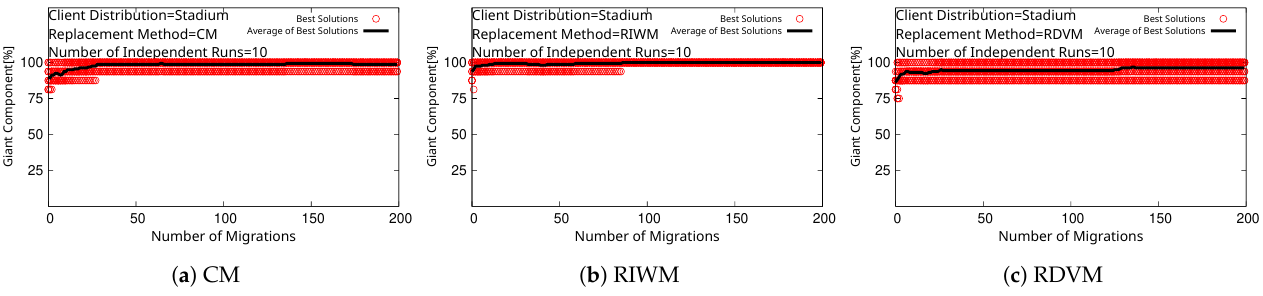
Figure 7. Simulation results of WMN-PSOSA-DGA for SGC.